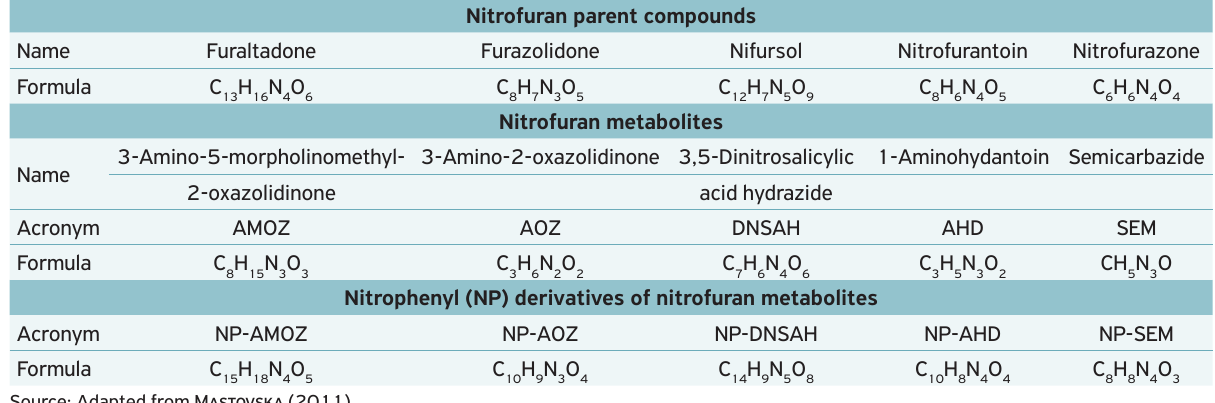
Table 1. Nitrofurans, their metabolites and derivatization products: compound information and typical MS/MS conditions for the metabolites derivatized with 2-nitrobenzaldehyde (nitrophenyl